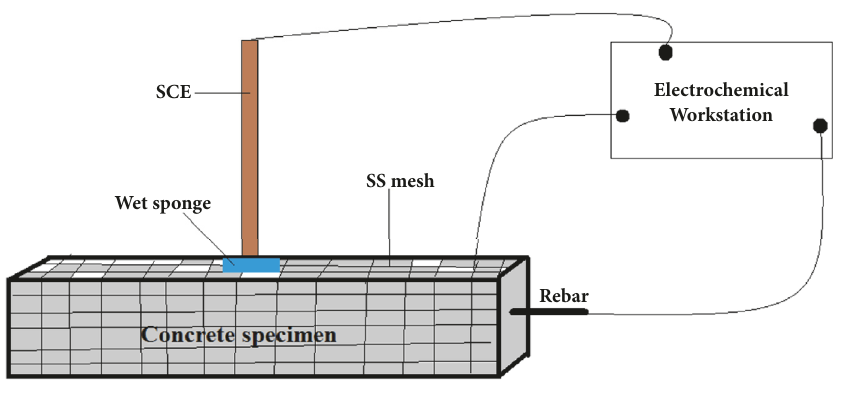
Figure 1: Three-electrode circuitry for electrochemical